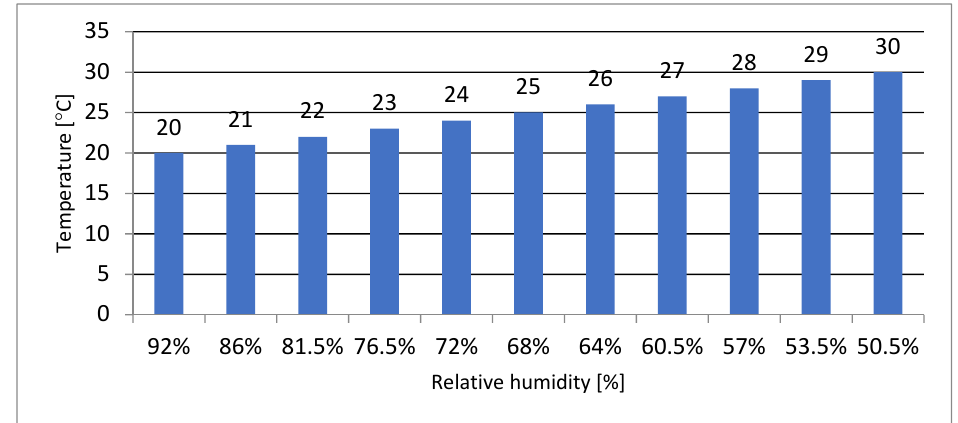
Figure 8. Dependence of temperature [° C] on relative humidity [4].